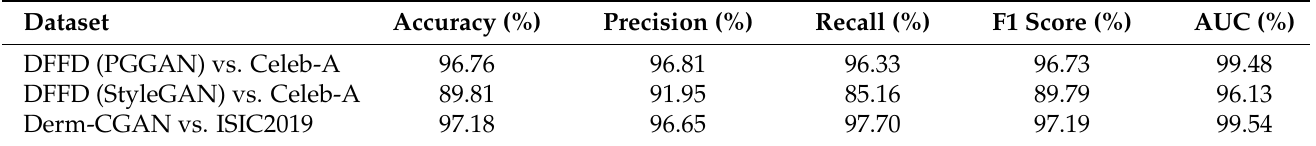
Table 6. Performance Analysis of ViT128/32 on DFFD benchmark data.